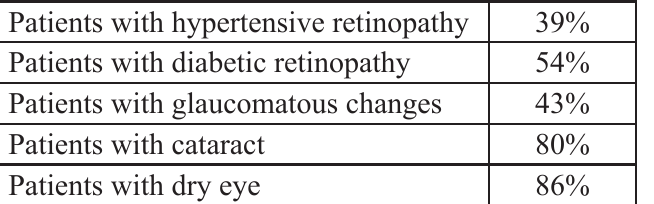
Table 1 : Percentage of practitioners encountering pathology